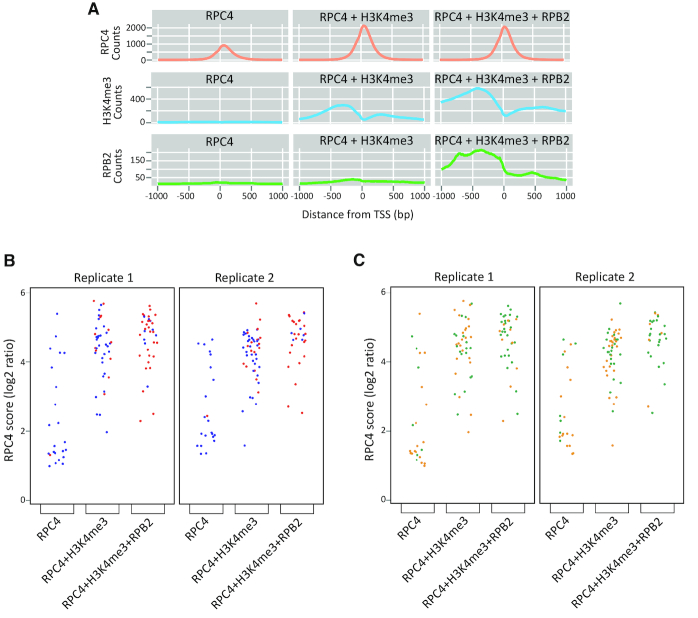
(A) Average tag density profiles for the factors indicated in the left, for the isolated tRNA gene groups (columns). The profiles were computed from replicate 2. (B) Scatterplots of RPC4 scores for isolated tRNA genes in replicate 1 and 2. The grouping into tRNA gene groups was done for each replicate independently (for H3K4me3, only replicate 2 was used). P-value < 2e–4 for the two comparisons in both replicates (see text), permutation based t test with 10000 permutations. Red and blue dots, genes with and without associated CpG islands, respectively. (C) As in B, but the orange and green dots indicate genes >2.65 kb and <2.65 kb, respectively, from TSS or poly A site of Pol II genes.